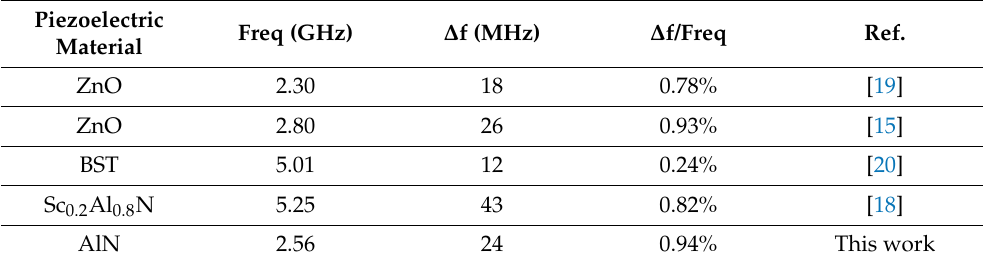
Figure 7. ( a ) The test results of the FBARs with support columns of different widths. ( b ) The measured performance dependence of FBARs with support columns of different widths. Table 2. Comparison to other published device